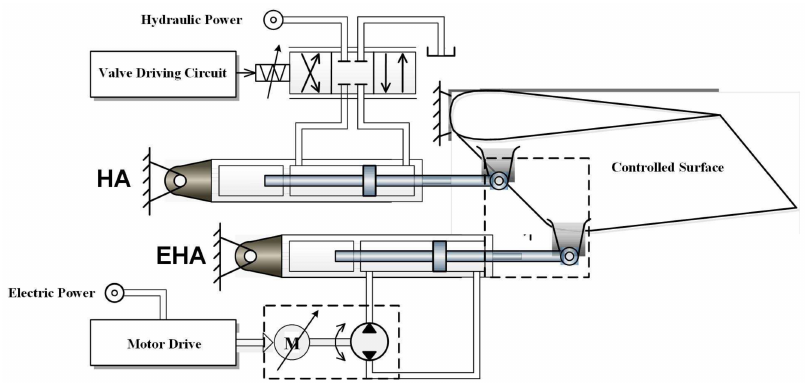
Figure 4. Configuration of actuation system with one HA and one